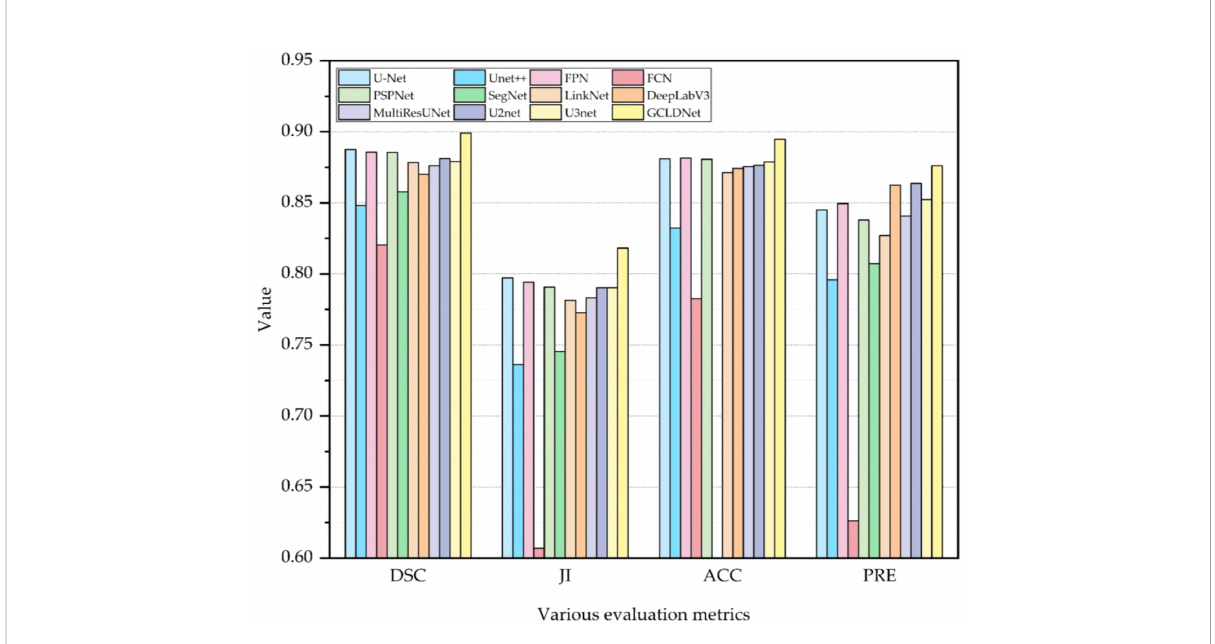
FIGURE 8 Visual comparison of the performance of different models on BOT